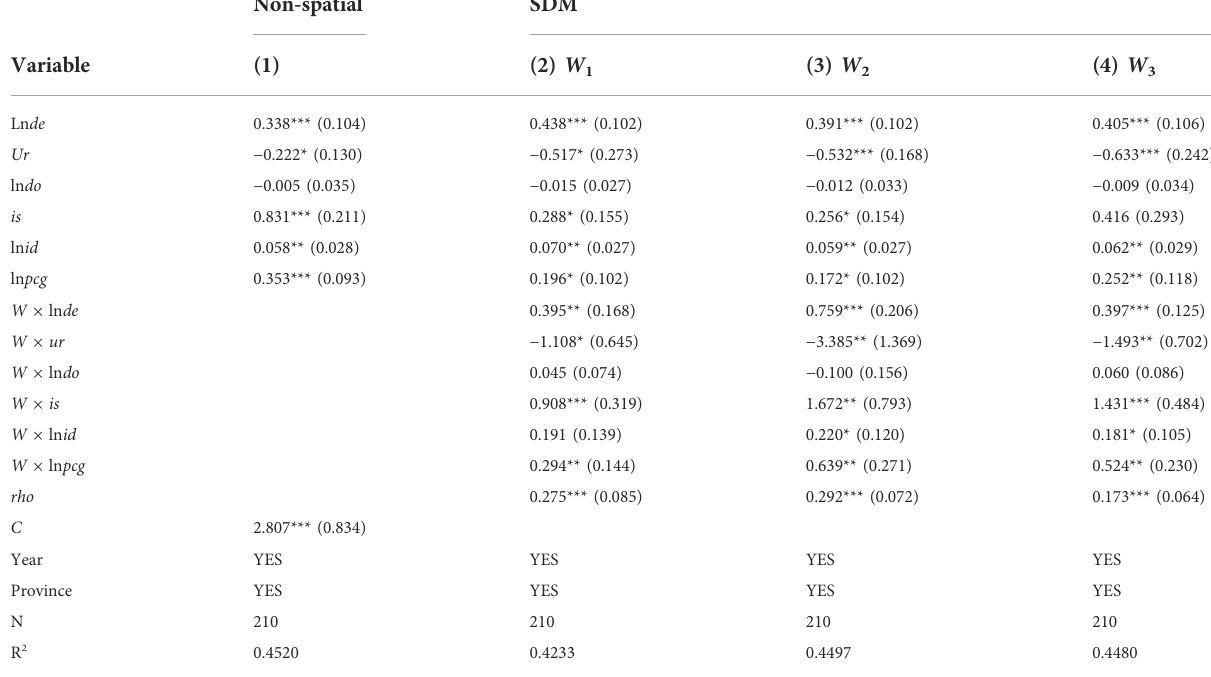
TABLE 6 Regression results.